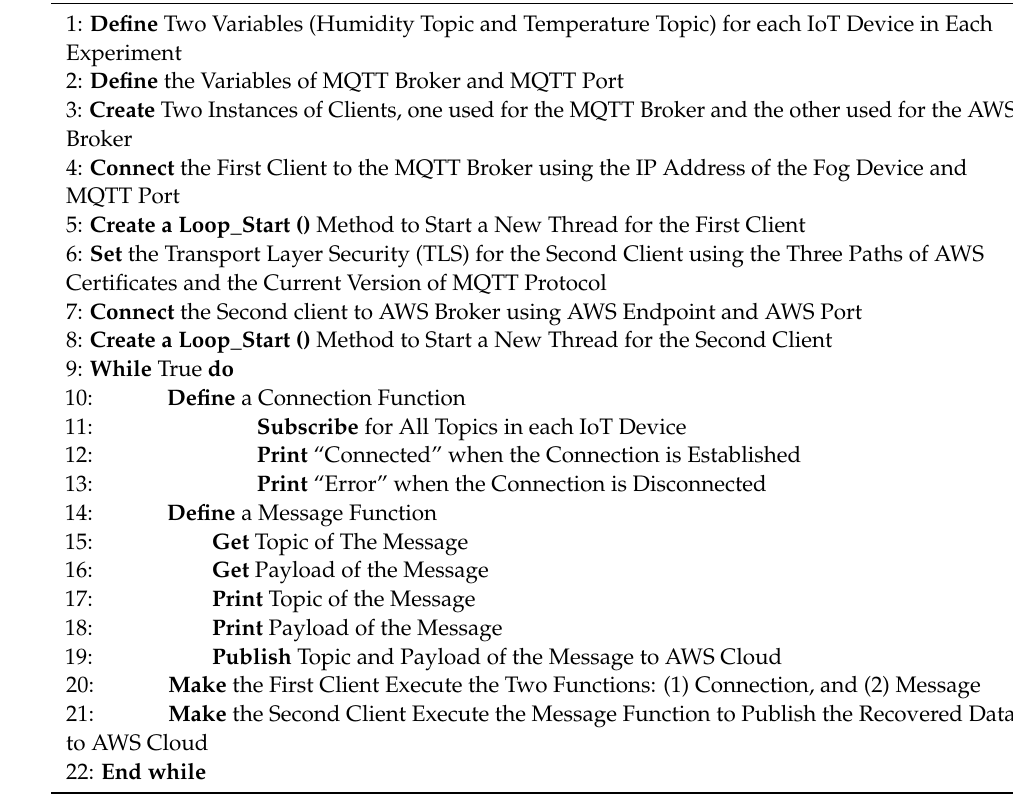
Algorithm 3. Receive data from the IoT devices and forward it to the cloud/*. This algorithm authenticates the IoT device to the MQTT broker on the fog device, subscribes to the data received from the sensors via the MQTT broker, filters the data based on topics, authenticates to the AWS via certificates, and then publishes the filtered data to the AWS IoT core